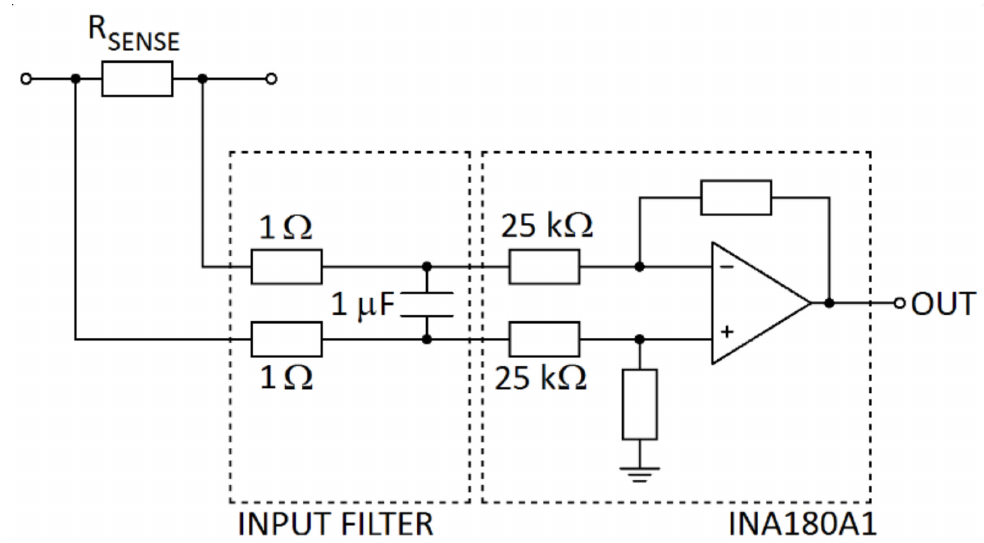
Figure 6. Input filter of the differential